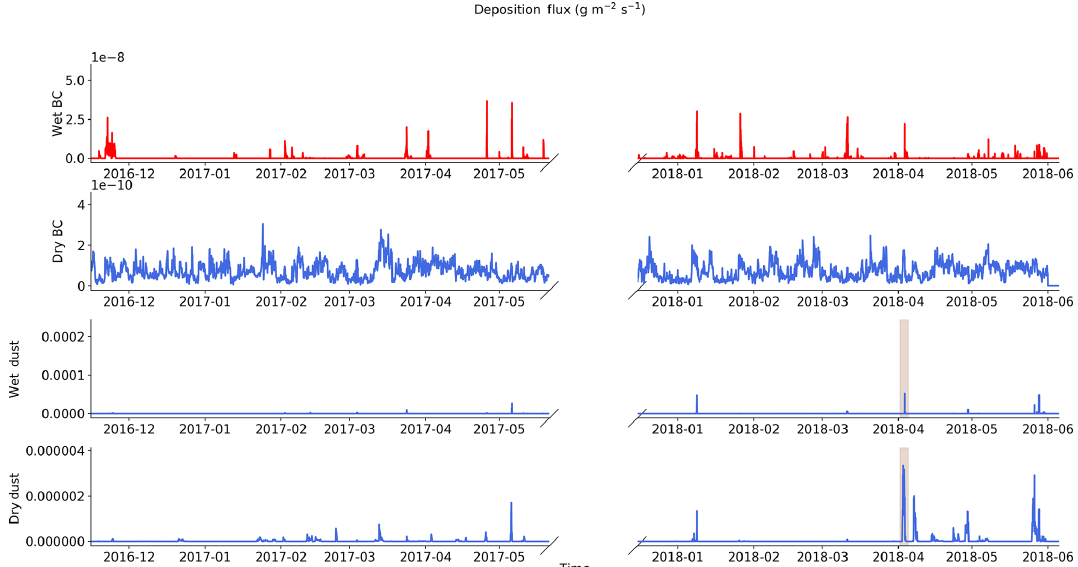
Figure B1. Different component of the ALADIN-Climate deposition fluxes used as inputs for the Crocus snowpack model. The strong dust deposition event that occurred in April 2018 is represented by a brown shading. The different panels correspond to wet and dry deposition fluxes for BC (two upper panels) and dust (two lower panels) (all expressed in gm − 2 s − 1